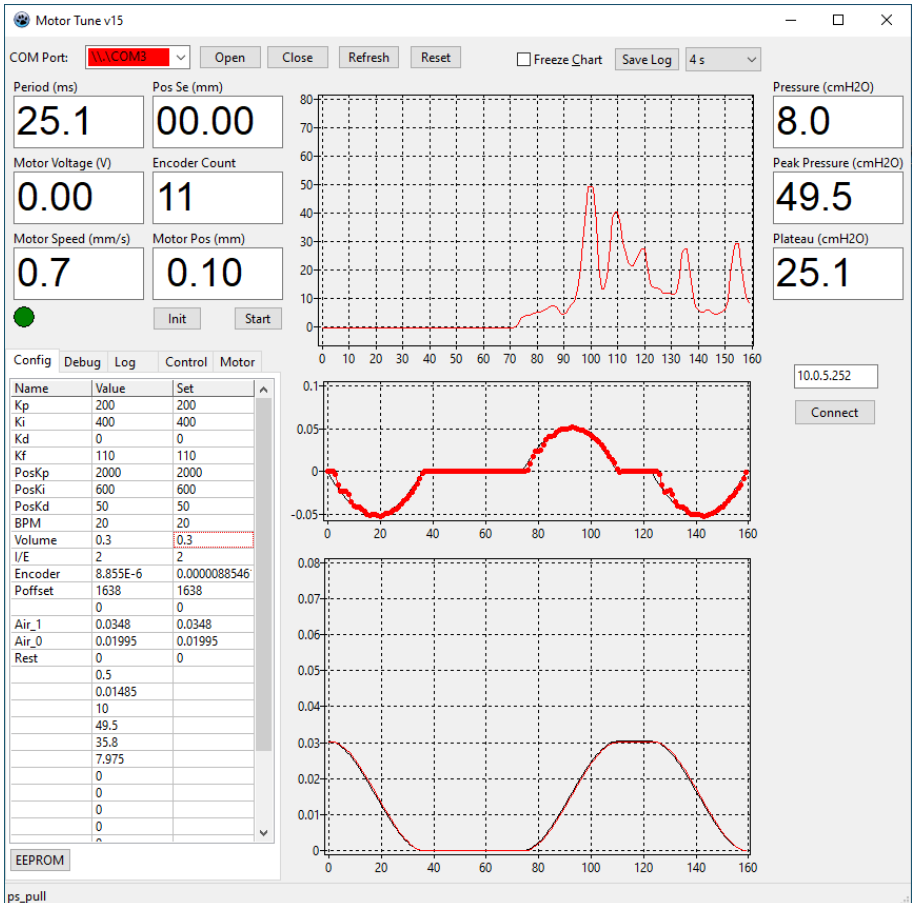
Fig. 10. Laptop application for setup, tuning and